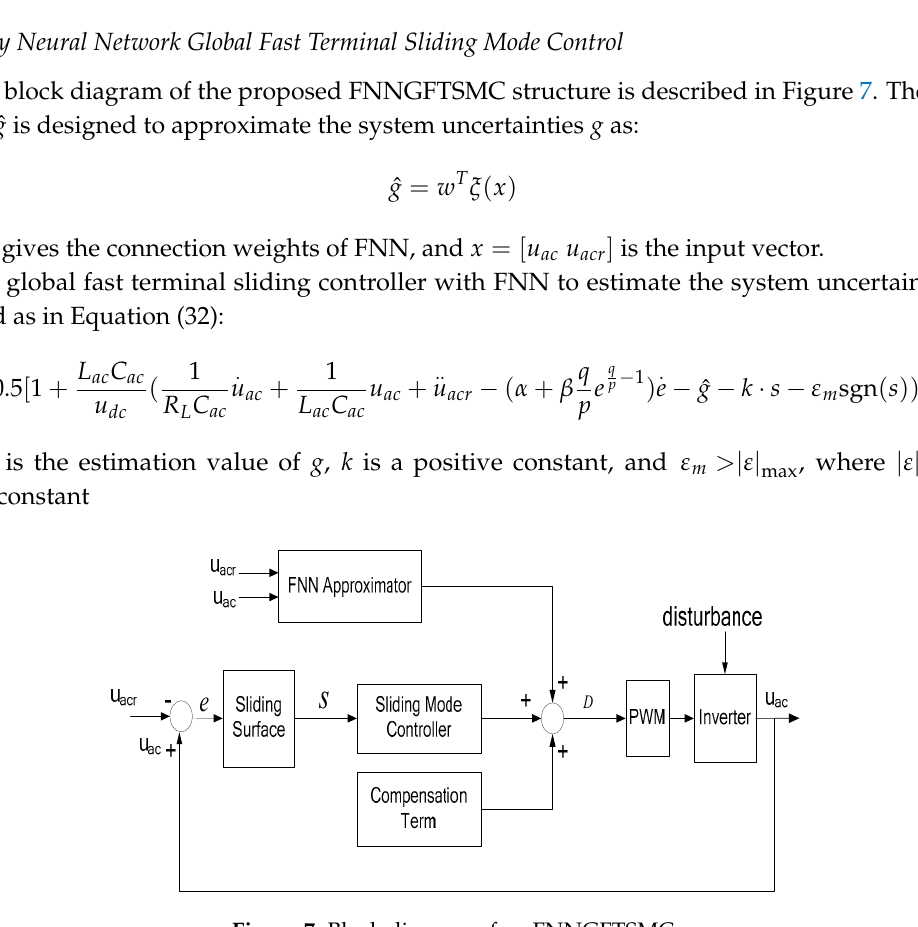
Figure 7. Block diagram of an FNNGFTSMC.